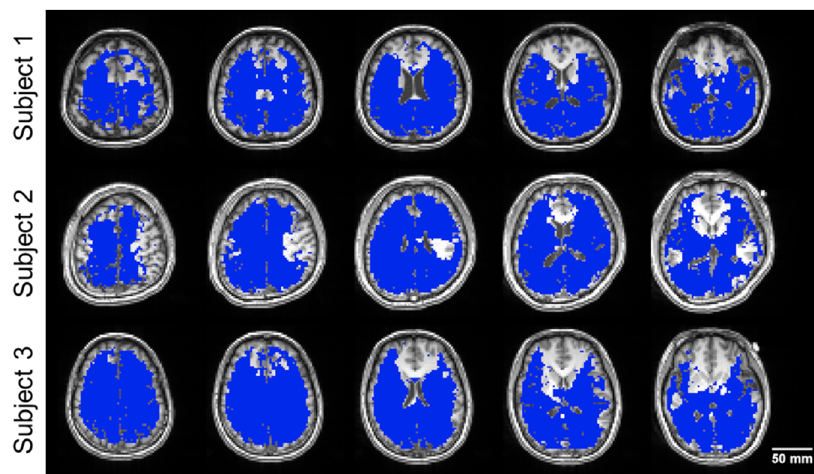
Fig. 6 Comparison of magnetic resonance (MR)-measured and model-predicted brain temperature maps. Blue voxels indicate differences between MR- measured and model-predicted brain temperatures within the threshold of |0.8 °C| (see “ Methods ” section) for the same axial slices shown in Fig. 5. MR thermometry was acquired across most of the brain, with the exception of portions of the frontal lobe. MR acquisition volumes are shown in Supplementary Fig. 2. The scale bar is 50 mm and all the images are on the same